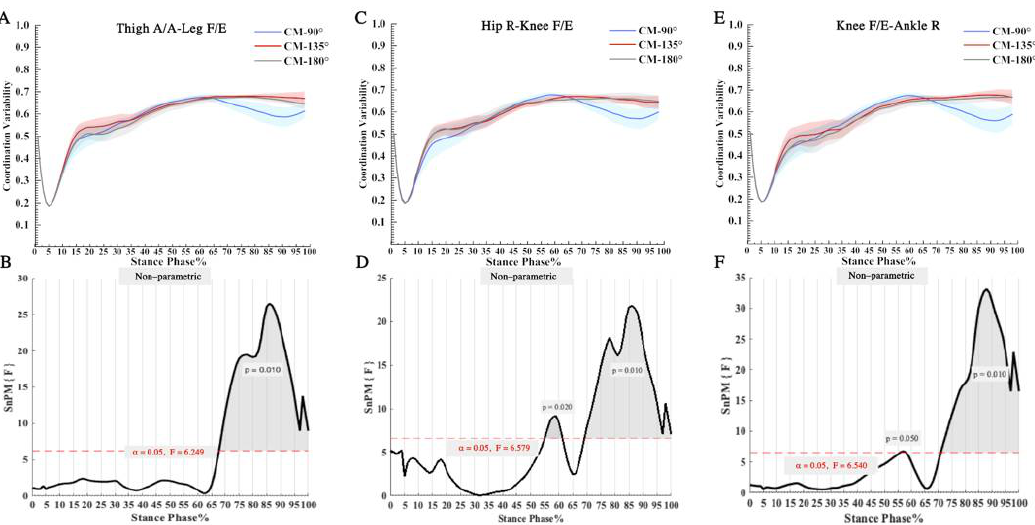
Figure 4. ( A ) The coordination variability of Thigh A/A-Leg F/E; ( B ) The SnPM statistics comparison of the coordination variability of Thigh A/A-Leg F/E; ( C ) The coordination variability of Hip R-Knee F/E; ( D ) The SnPM statistics comparison of the coordination variability of Hip R-Knee F/E; ( E ) The coordination variability of Knee F/E-Ankle R; ( F ) The SnPM statistics comparison of the coordination variability of Knee F/E-Ankle R. Table 2. Vector-coding coefficients, mean (standard deviation), and Post hoc test.